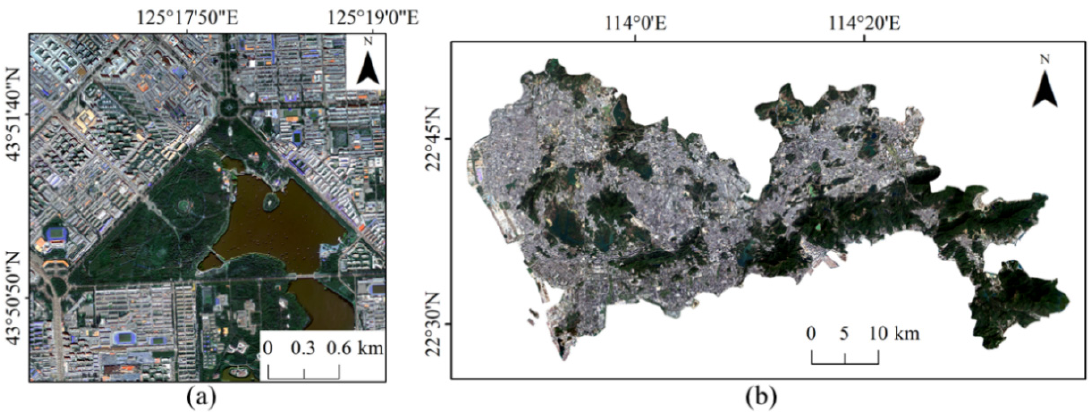
Figure 4. Image Data: ( a ) GF-2; ( b ) Sentinel-2.